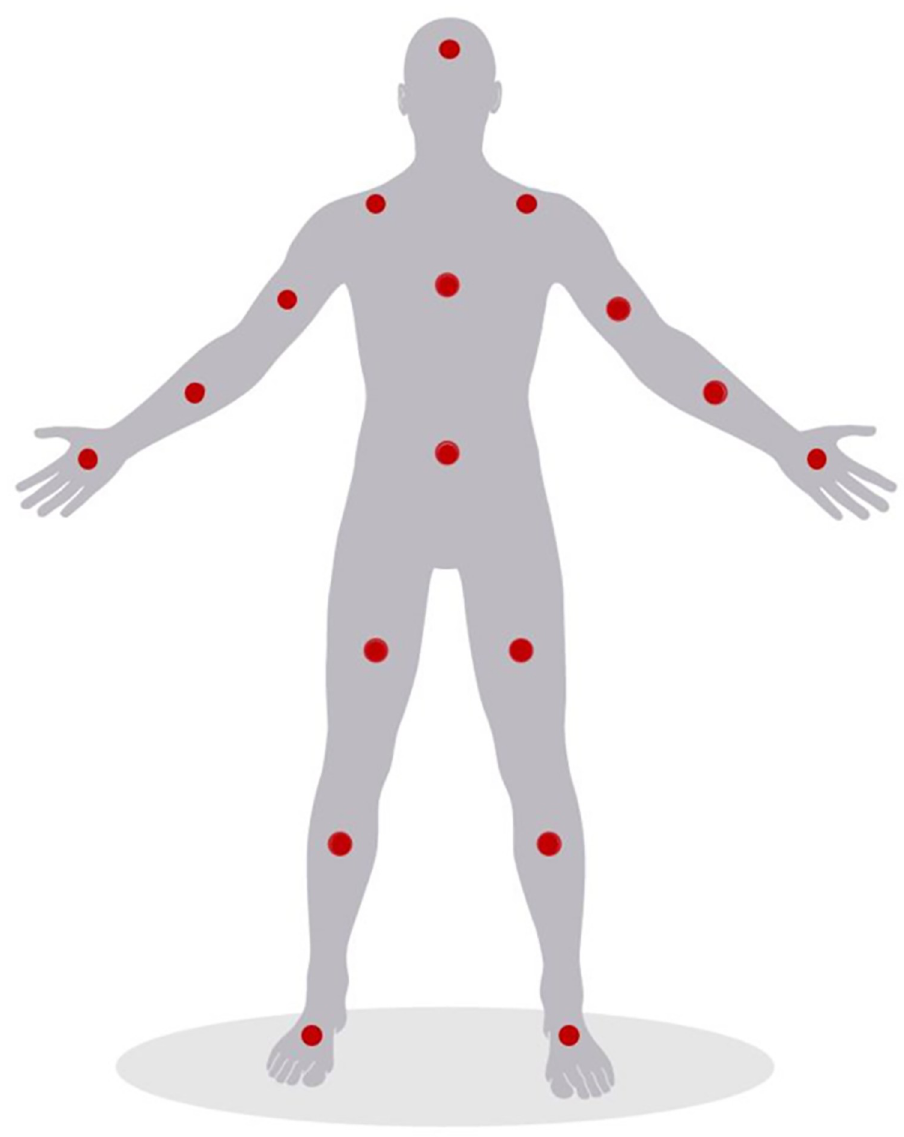
Fig 1. Perception Neuron IMU sensor configuration.